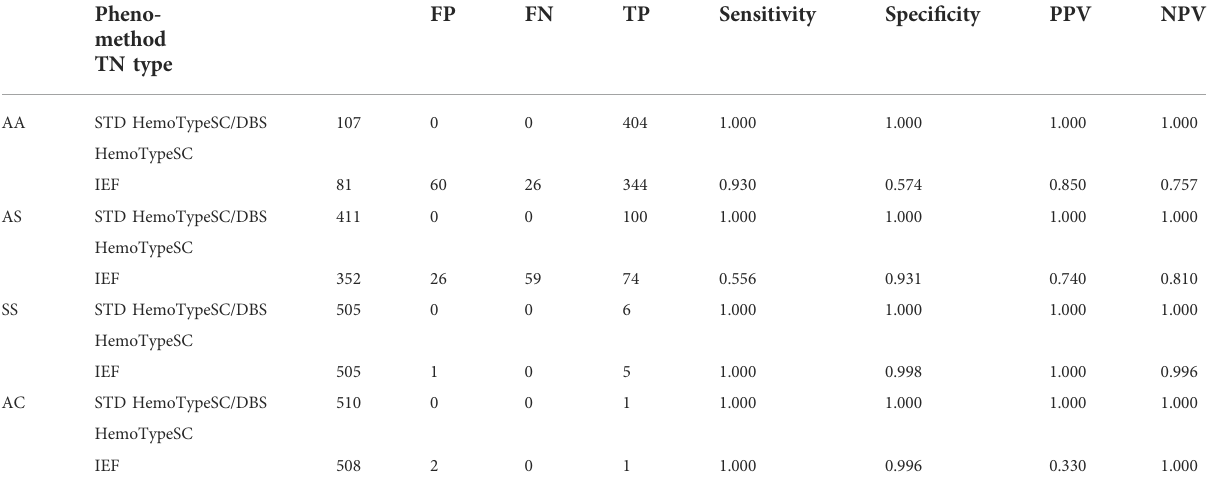
TABLE 4 Performance characteristics of DBS/POCT HemoTypeSC compared to IEF.